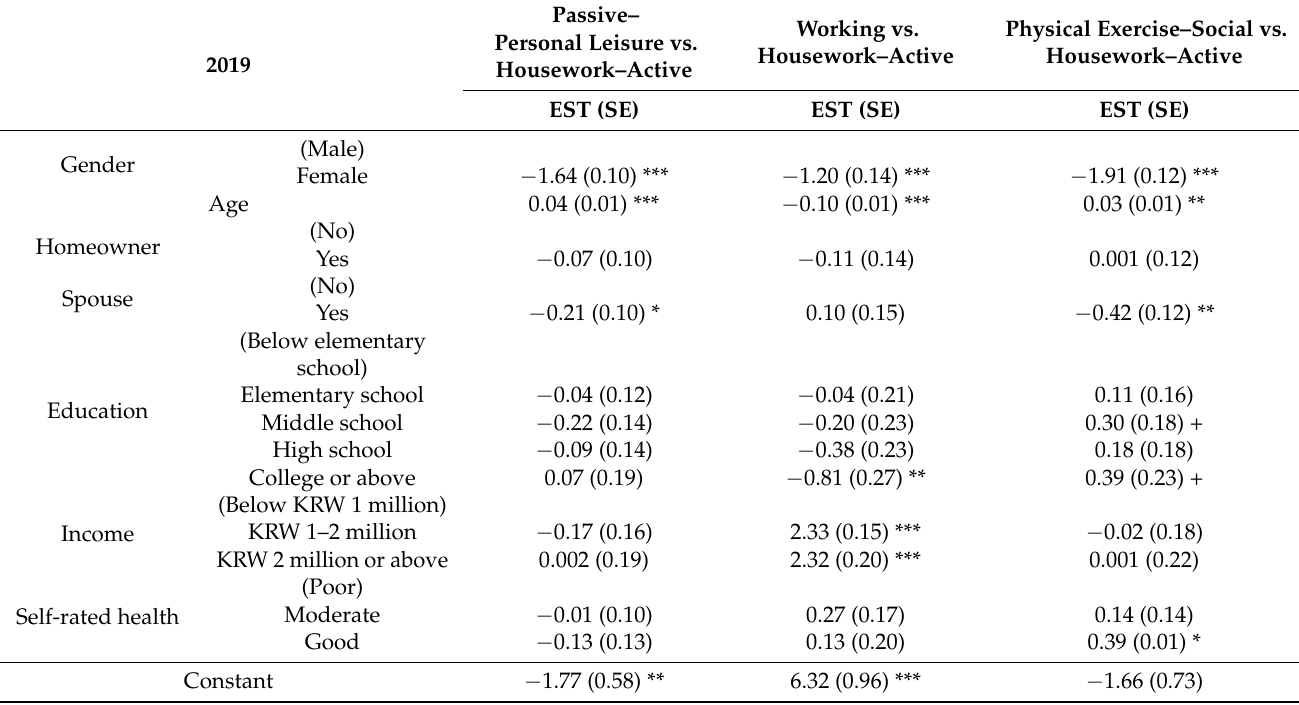
Table 8. Socioeconomic factors associated with activity groups (KTUS 2019).